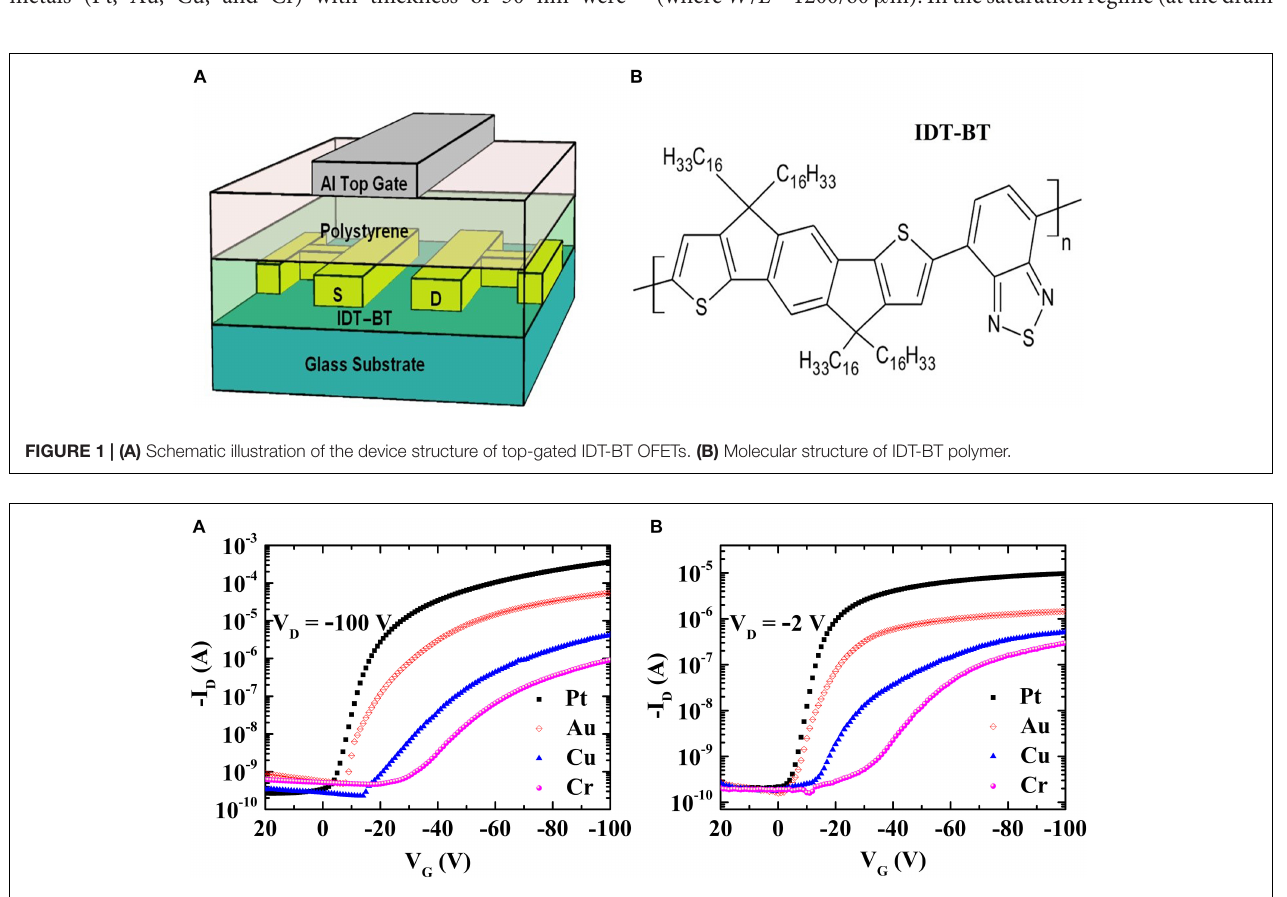
FIGURE 2 | (A) Saturation and (B) linear transfer curves of the IDT-BT OFETs with four different contact metals Pt, Au, Cu, and Cr, respectively.